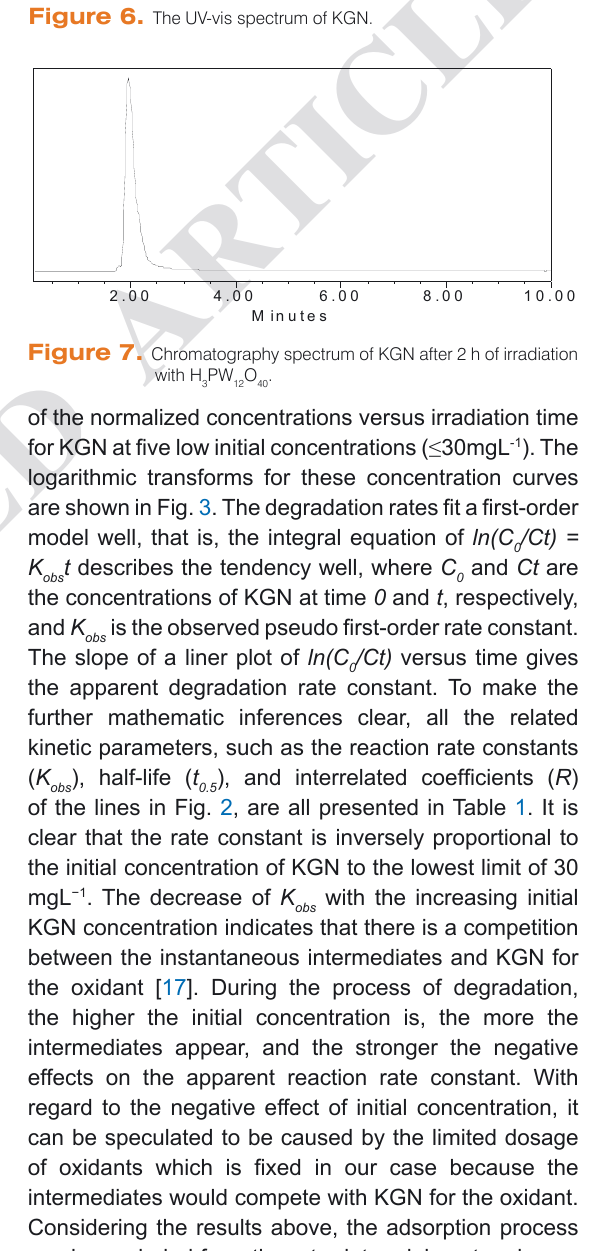
Figure 6. The UV-vis spectrum of KGN.